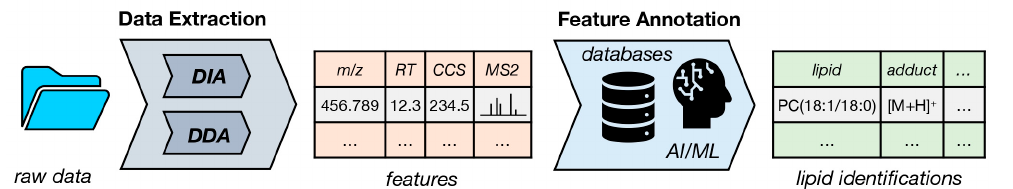
Figure 1. Generalized workflow for analysis of IMS-MS-based lipidomics data. Starting from raw data, either in original vendor format or converted to another format, the first step involves the extraction and processing of data to produce features. These features are defined by the measurement dimensions in the experiment, most commonly m / z , retention time (RT), IMS collision cross section (CCS), and MS/MS spectra (MS2) for LC-IMS-MS/MS experiments. The next step in the process is to assign lipid annotations to the extracted features using one or more of the measured properties of the features. Reference values for these properties may come from databases of previously measured values or predictions based on theoretical principles or empirically derived trends. The final result is a list of extracted features with associated lipid